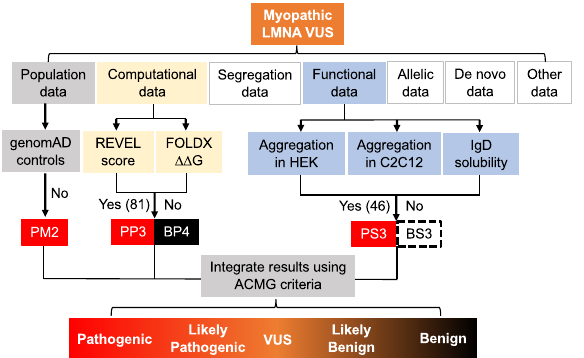
Fig. 6 Summary of how our data can support myopathic LMNA variant classi fi cation per ACMG guidelines. Flowchart showing